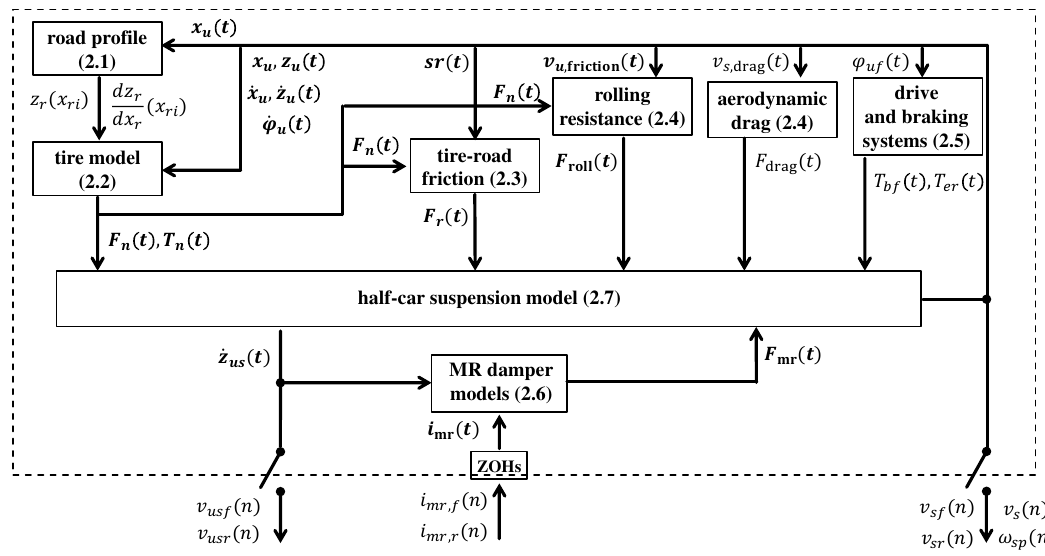
Figure 7. Block diagram of the simulation environment, section references are given in